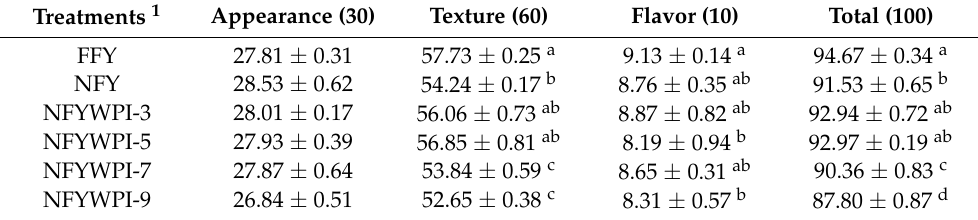
Table 2. The sensory properties of yogurt made using whey protein isolate (WPI). Treatments